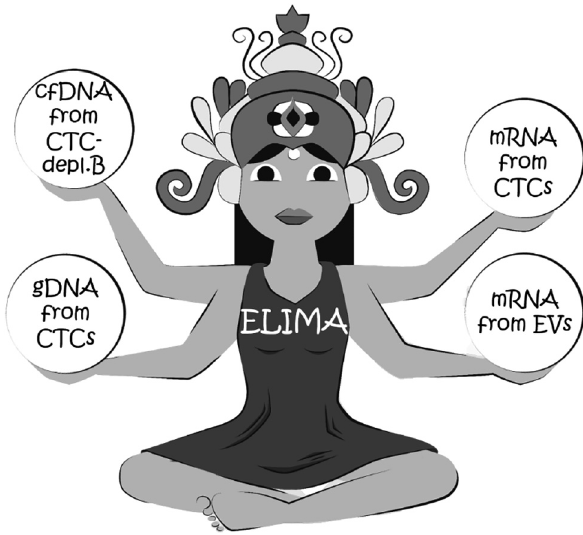
Figure 2: Blood analytes and logo of the ELIMA study.